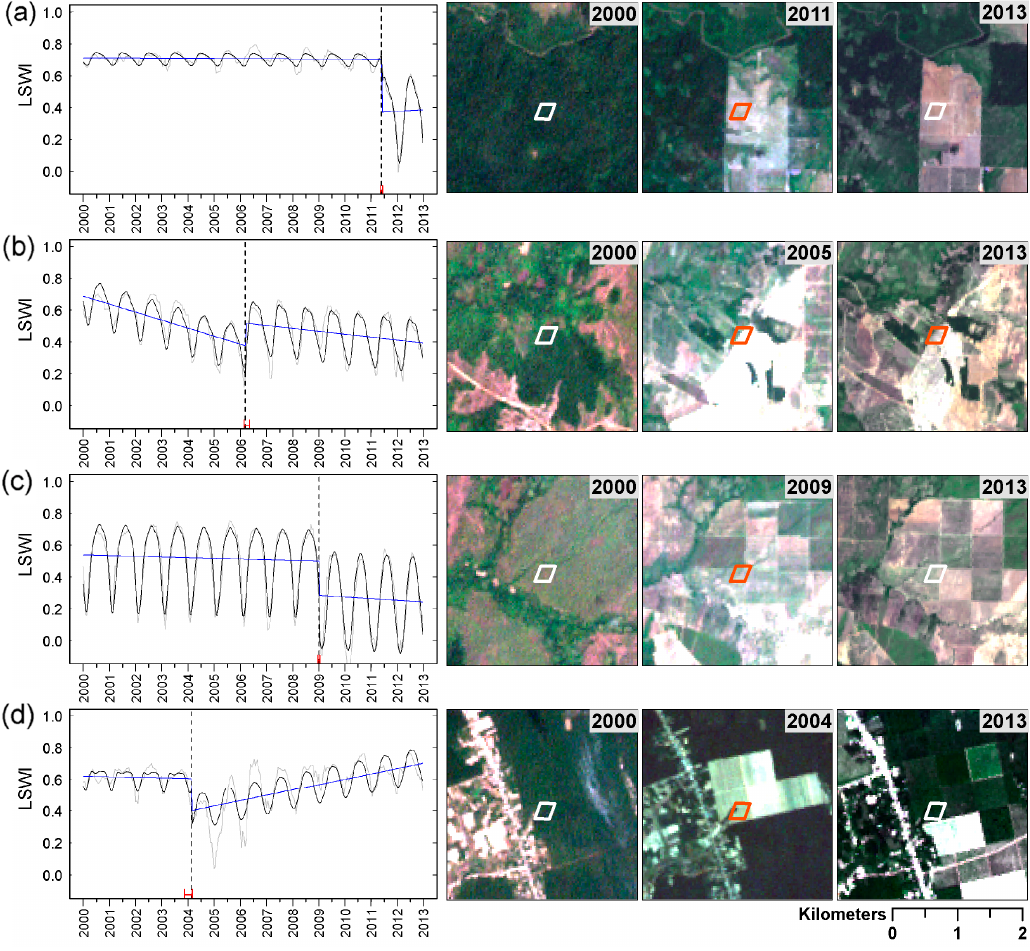
Figure 3. Examples of Breaks For Additive Season and Trend (BFAST) output using the Land Surface Water Index (LSWI) time series: ( a ) evergreen forest; ( b ) mixed forest; ( c ) dry-deciduous forest; and ( d ) rubber plantation. The panels to the right of each plot include true colour Landsat imagery for selected years before and after the detected forest clearance. The MODIS pixels used for each example are shown by the centred white and red outlines. For the plots, light grey = original time series, blue = fitted trend model, and black = fitted seasonal model.